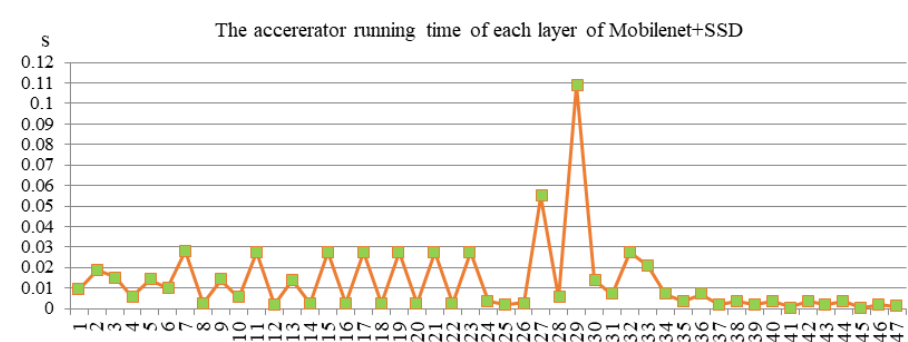
Figure 14. Accelerator running time results.